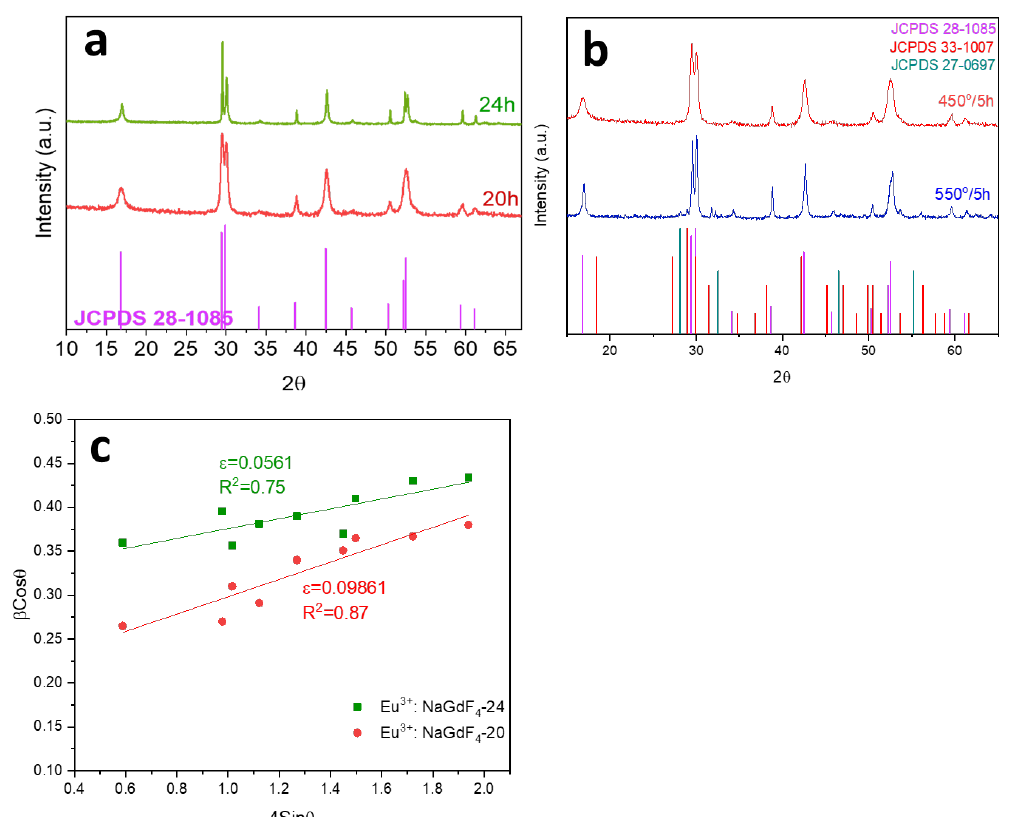
Figure 1. XRD patterns of ( a ) 1.5Eu 3+ : NaGdF 4 NPs synthesised for 20 h and 24 h at 180 °C in the autoclave; ( b ) 1.5Eu 3+ : NaGdF 4 NPs synthesised for 20 h at 180 °C and heat-treated at 450 °C and 550 °C for 5 h. ( c ) Williamson – Hall plot from the XRD of 1.5Eu 3+ : NaGdF 4 NPs synthesised for 20 h and 24